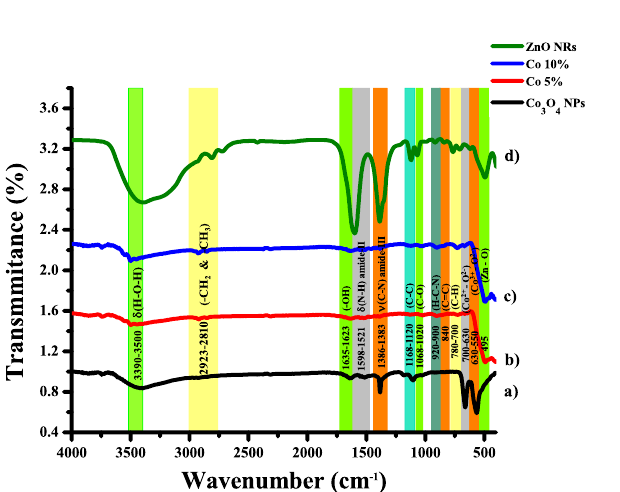
Figure 7. EDS analysis of ( a ) Co 3 O 4 NPs, ( b ) Co 5% nanocomposite, ( c ) Co 10% nanocomposite and ( d ) ZnO NRs.